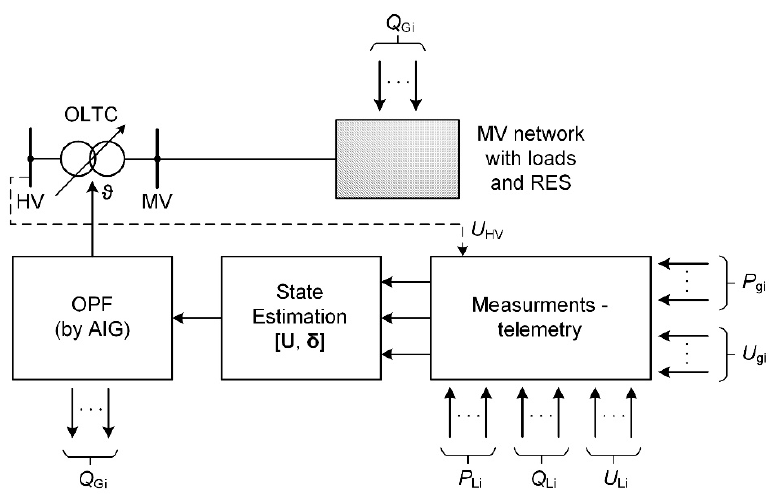
Figure 1. Diagram of the OPFh-MVt voltage control method, control signals—transformer ratio ϑ and reactive power of RES systems.